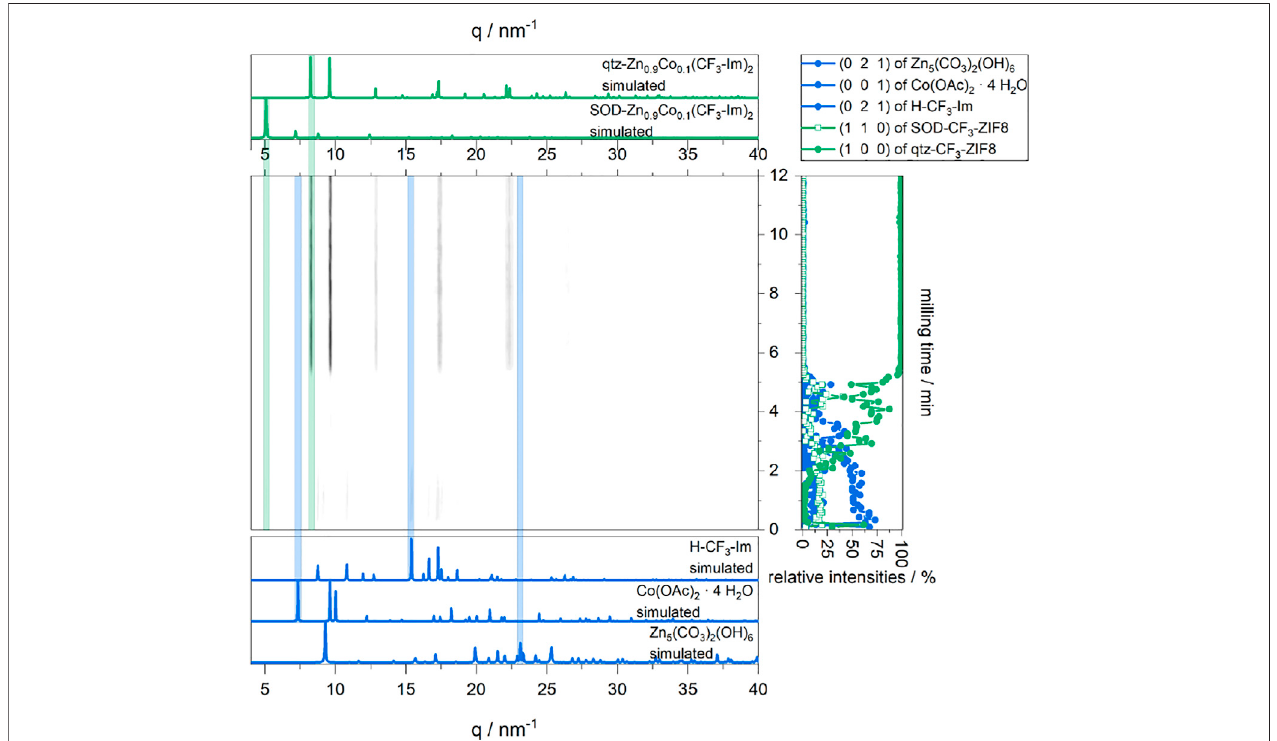
FIGURE 6 | In situ XRD plot of the formation of qtz-Zn 0.9 Co 0.1 (CF 3 -Im) 2 (center). For comparison, the simulated XRD patterns of starting materials (blue, bottom) and the products (green, top) are shown. The intensities of chosen re fl ections of the present phases are plotted on the right.